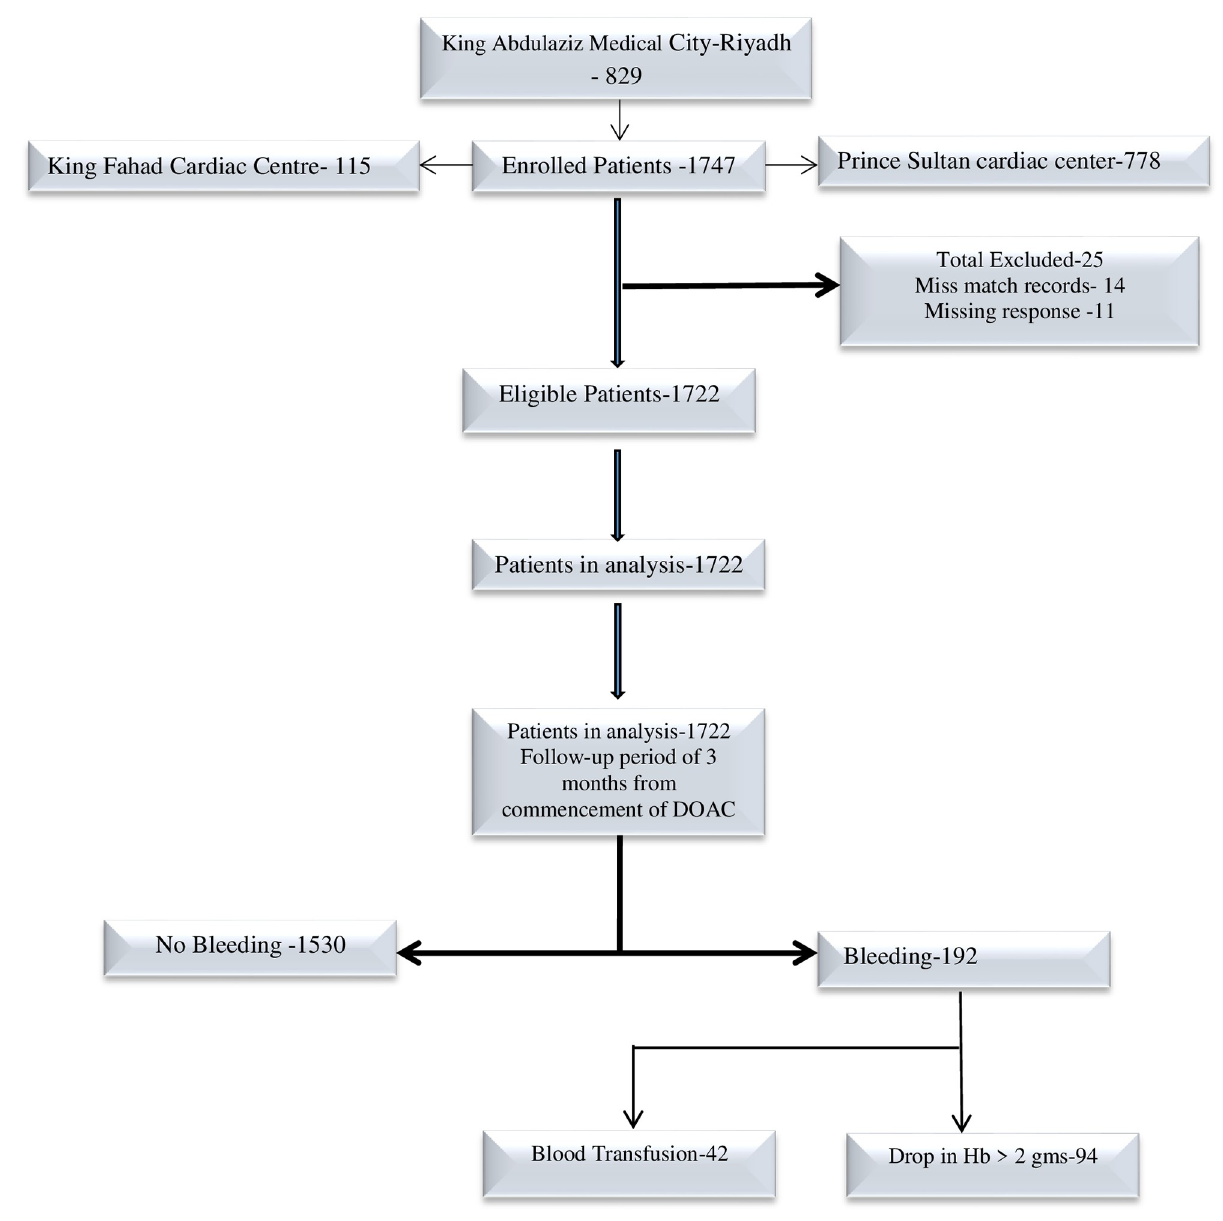
Fig 1. Derivation of study